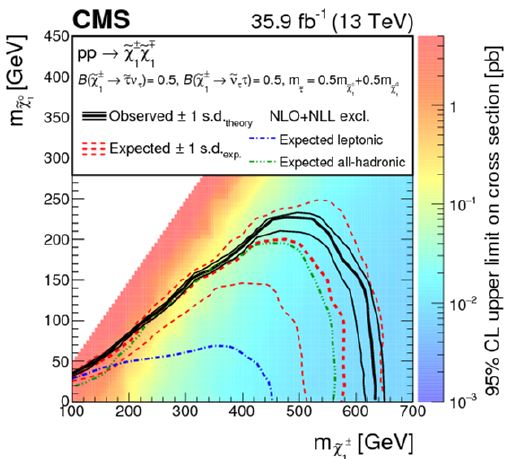
Figure 8: Exclusion limits at 95% CL for chargino pair production with decays through ˜ τ to final states with τ leptons [ 15 ]